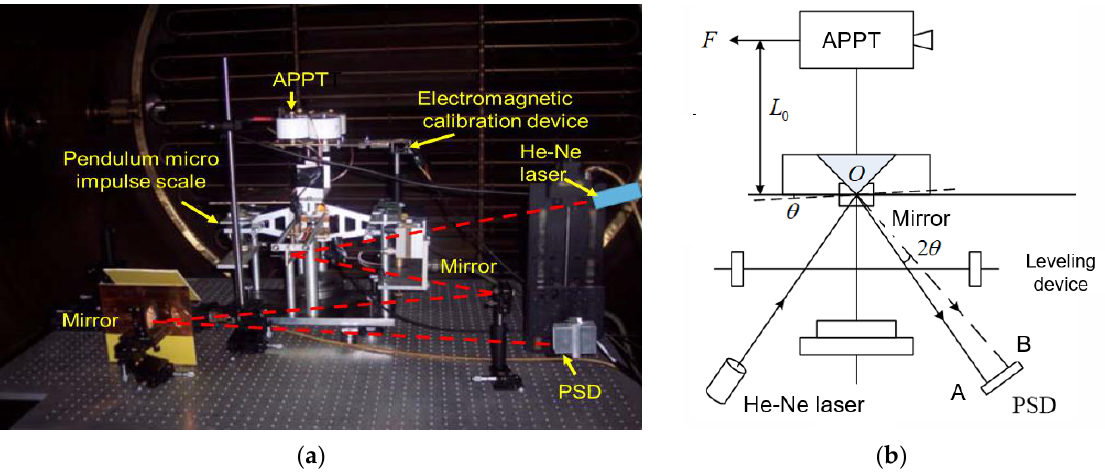
Figure 6. ( a ) Pendulum micro impulse scale and ( b ) a schematic diagram of working principle.